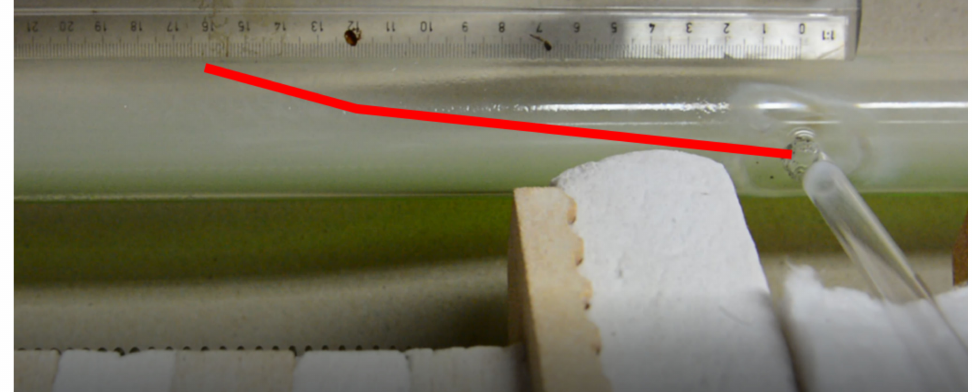
Figure 14. Nitrogen flow = 5 L/min, where the wedge profile of H 2 in the evaporation zone is clearly